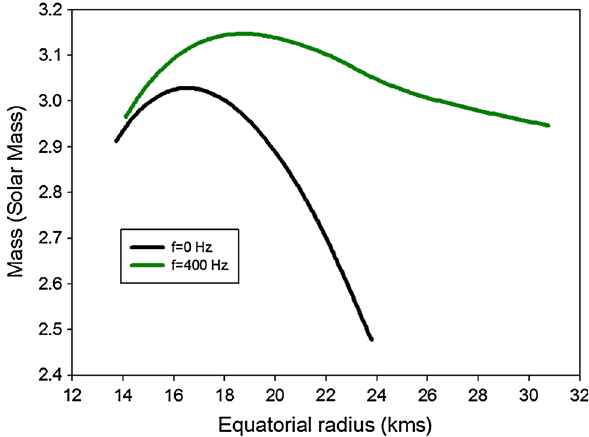
Fig. 4 Mass–equatorial radius plots for static and rotating fermionic asymmetric dark matter stars